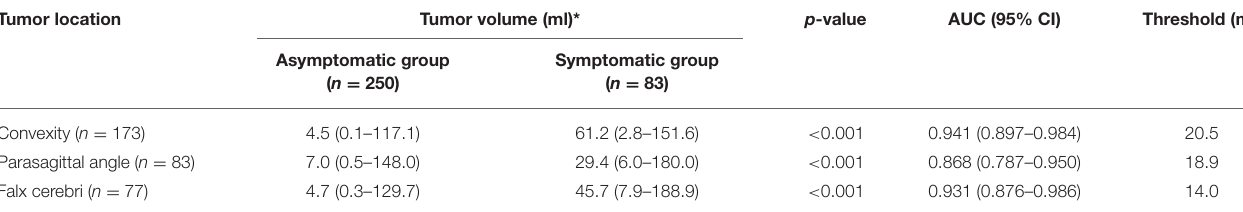
TABLE 3 | Comparison by tumor